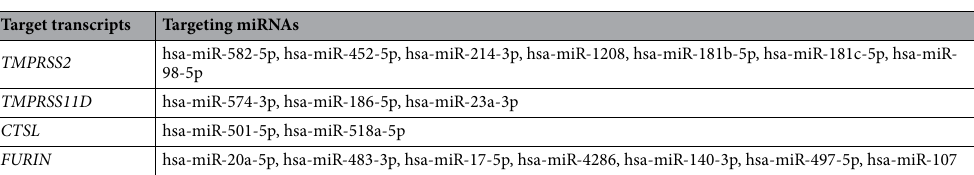
Table 2. Enoxacin-induced miRNAs that can target membranous proteases facilitating SARS-CoV-2